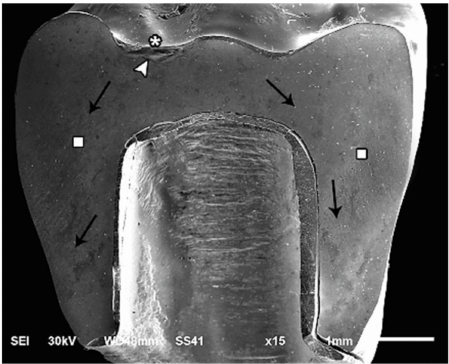
Figure 8. SEM micrograph represents class II failure mode of lithium disilicate fractured specimen showing fracture origins (asterisk) at the loading occlusal surface of the restoration and hackle lines (square) indicating the direction of crack propagation (black arrow), arrest line (arrow-head).